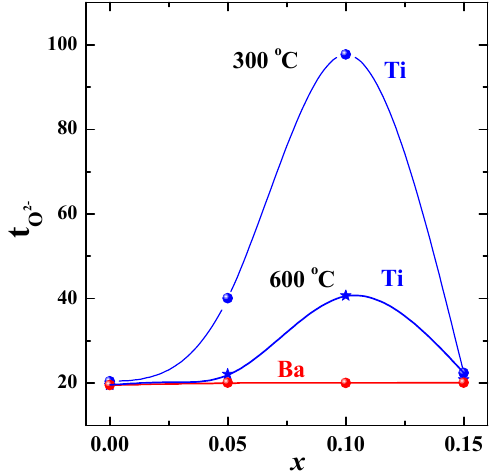
Figure 13. The concentration dependencies of oxygen-ionic conductivities (filled symbols) and acti- vation energies (open symbols) for the solid solutions Ba 1+ x La 1 − x InO 4 − 0.5 x (red) [79] and